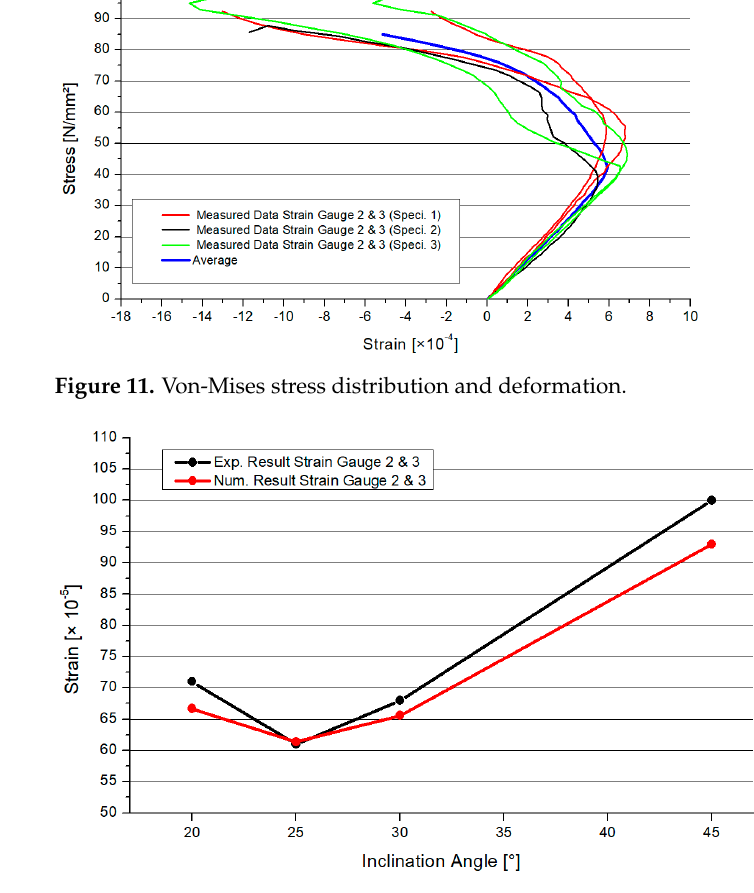
Figure 11. Von-Mises stress distribution and deformation.